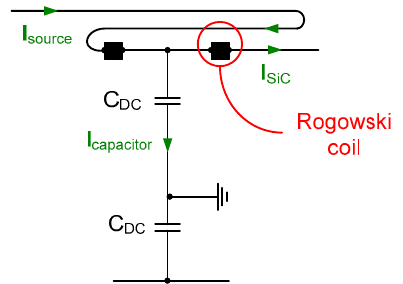
Figure 21. Measurement method to get the DC capacitor current: embracing with a Rogowski coil I SiC and I source.